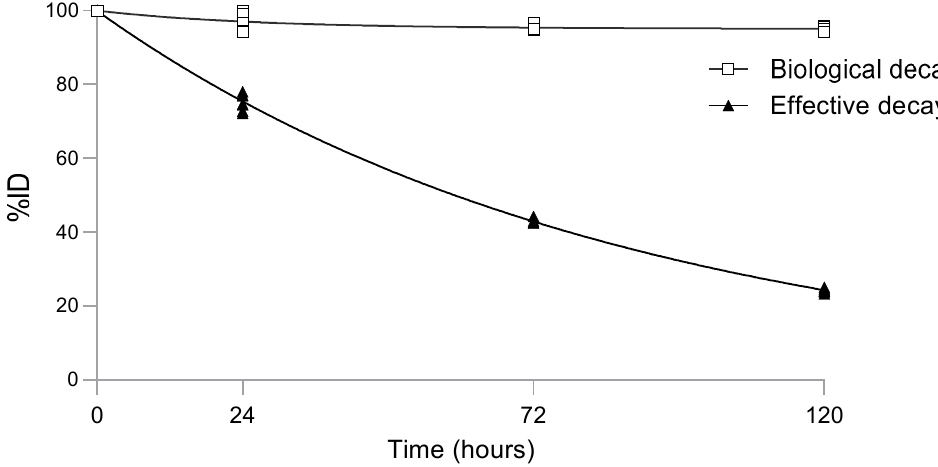
Figure 3. Whole body clearance of 4497- 111 In in seven mice. Curve fitting using nonlinear regression analyses (r 2 = 0.998) showed that the effective half-life of 4497- 111 In was 59 h. The biological clearance as a percentage of the injected dose was 2.97 ± 2.23, 4.56 ± 0.79 and 4.92 ± 0.59% at 24, 72 and 120 h, respectively. The biological decay reached a plateau phase between 24 and 72 h.